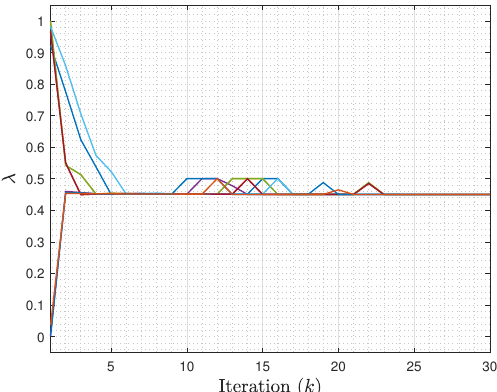
Figure 3. Variable λ ∈ [ 0,1 ] defining the time-varying terminal set E λ .